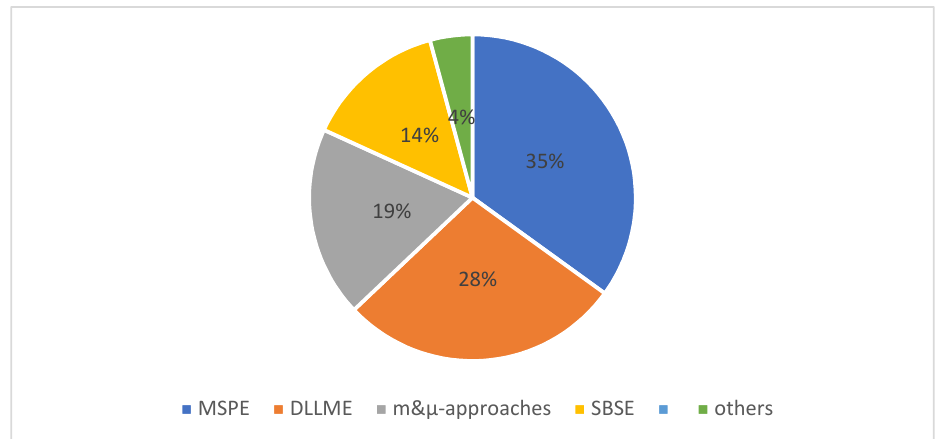
Figure 3. Consolidated summary of the magnetic applications in sample preparation methods.